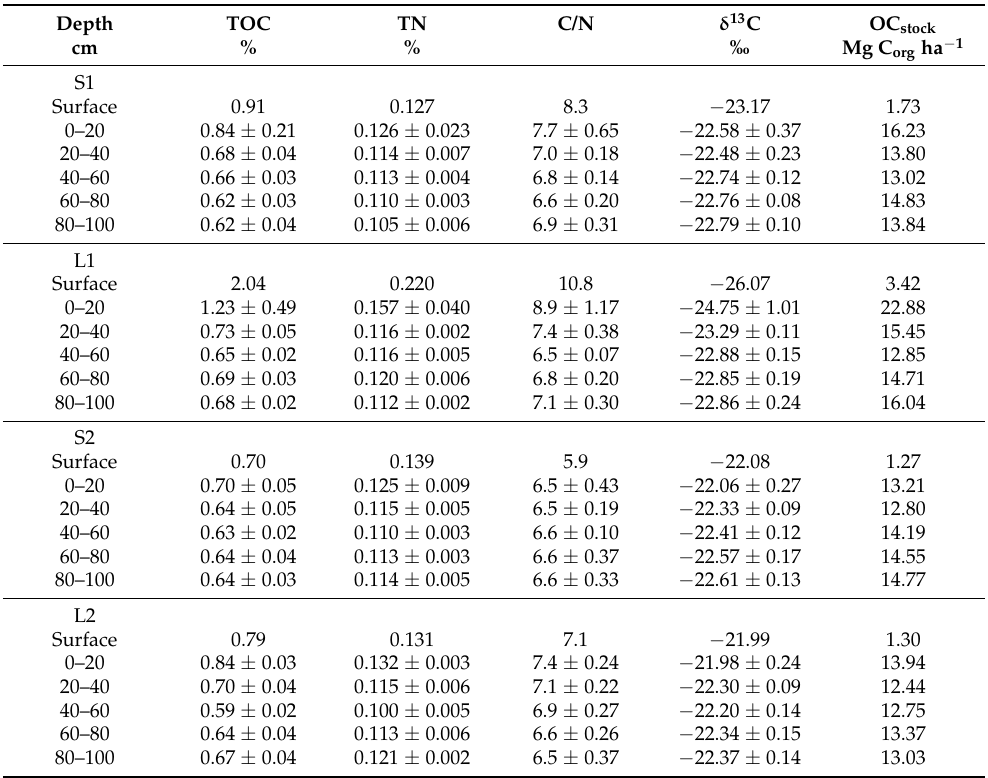
Table A2. Results of TOC, TN, C/N, δ 13 C and OC stock